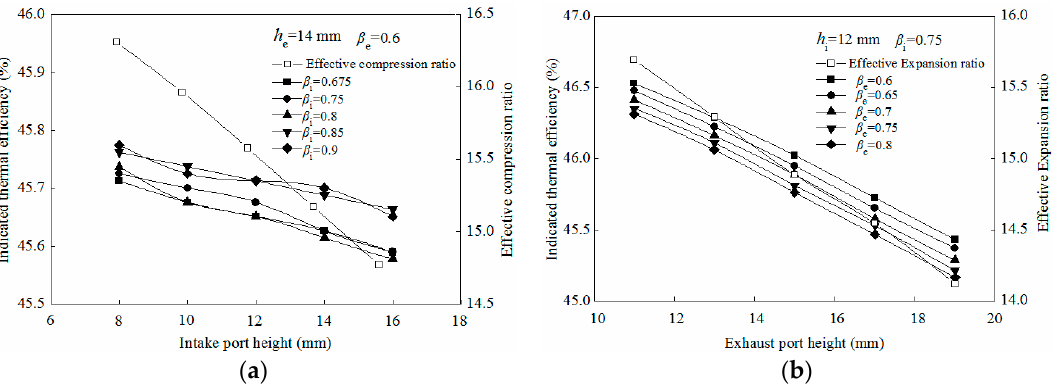
Figure 11. Effect of the port height and circumference ratio on scavenging efficiency ( a ) Intake port; ( b ) Exhaust port.